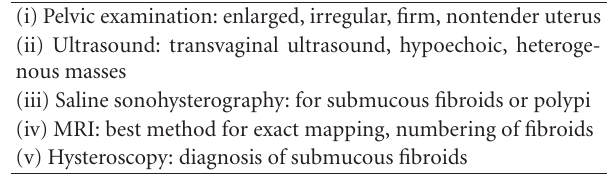
Table 1: The clinical presentation of uterine leiomyomas. Table 2: Diagnosis of uterine